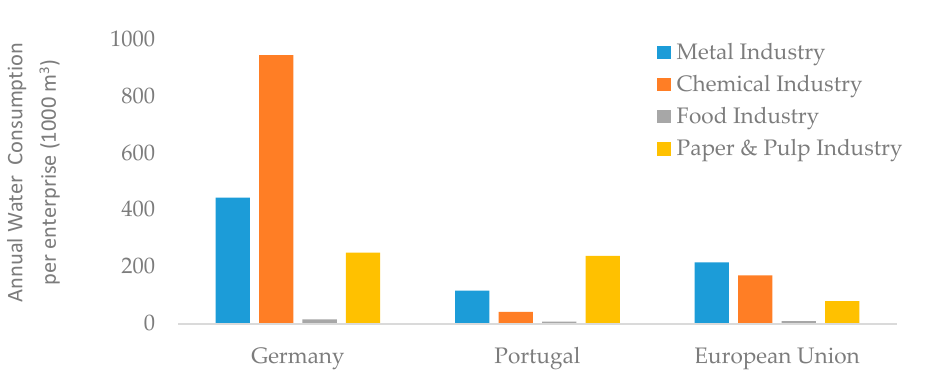
Figure 3. Average water consumption for each industrial sector and region (adapted from [1,36,39]).